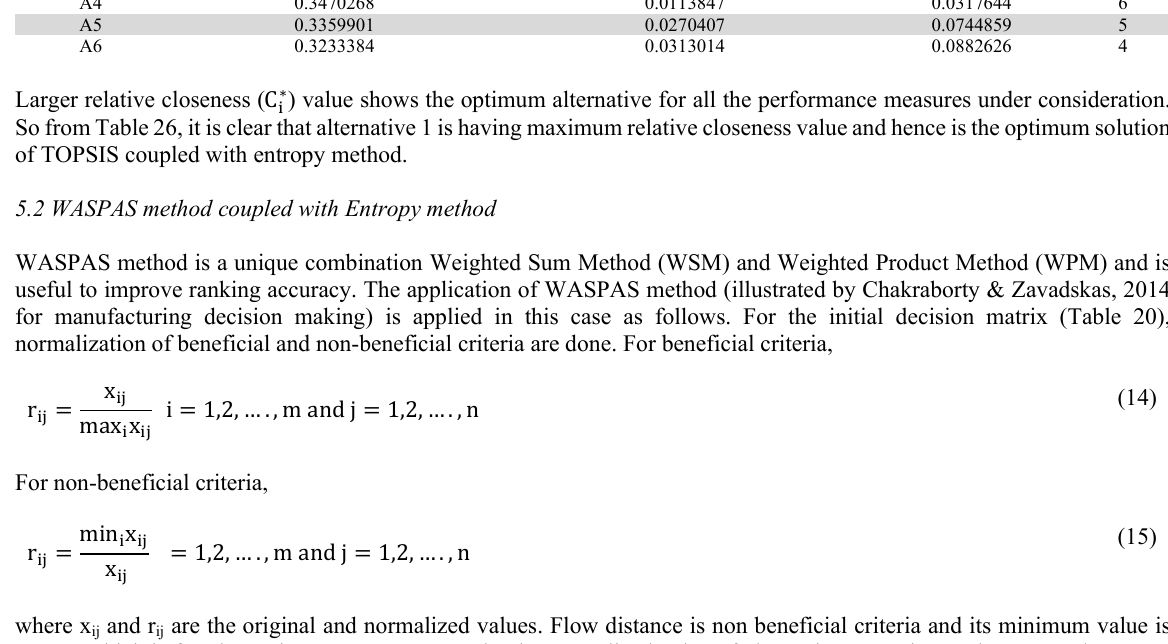
Separation measure of negative ideal solution (S (cid:2919)(cid:4593) )